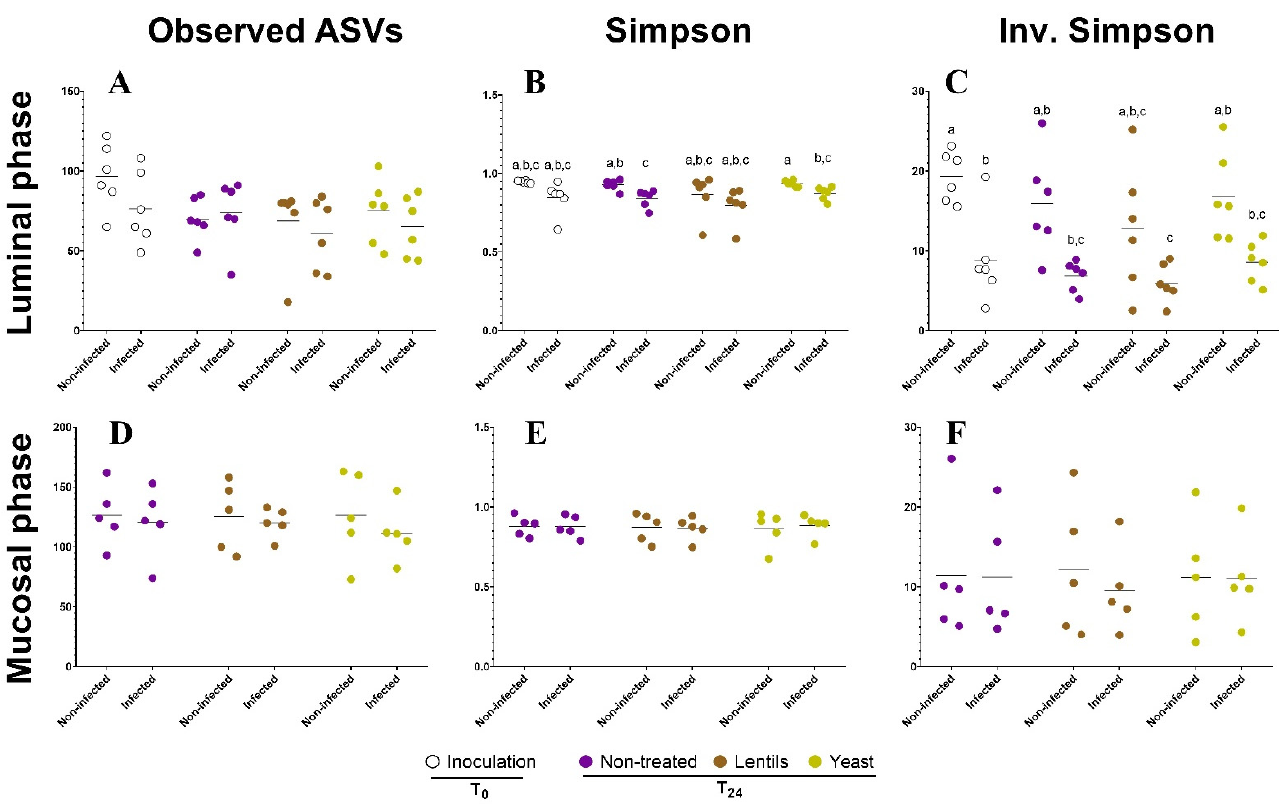
Figure 9. Impact of the dietary-fiber-containing products on the ETEC modulation of microbial community α -diversity. Batch experiments were performed using feces from six healthy donors, challenged or not with ETEC strain H10407 and treated or not with fiber-containing products. The graphs represent the variation in the microbiota species richness ( A , D ) and species evenness represented by the Simpson ( B , E ) and inverse Simpson indexes ( C , F ) at the ASV level. Samples were collected in both the luminal ( A – C ) and mucosal compartments ( D – F ). White, purple, brown, and yellow dots represent individual biological replicates at the beginning of the experiment after ETEC inoculation (Inoculation, T 0 ) or after 24 h of fermentation in the non-treated (Non-treated, T 24 ), lentil extract (Lentils, T 24 ), or specific yeast cell walls (Yeast, T 24 ) conditions, respectively. Black bars represent the means ( n = 6). Results that are not significantly different from each other according to Tukey’s multiple comparisons tests are grouped under the same letter ( p < 0.05).